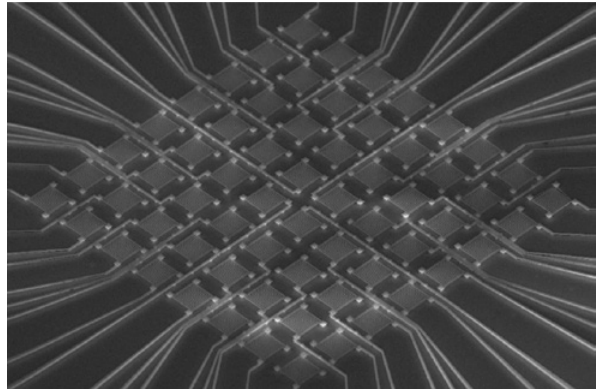
Figure 17: Scanning electron microscopy image of a fabricated 8 × 8 MEMS HCG array. Reprinted by permission of The Optical Society [62].